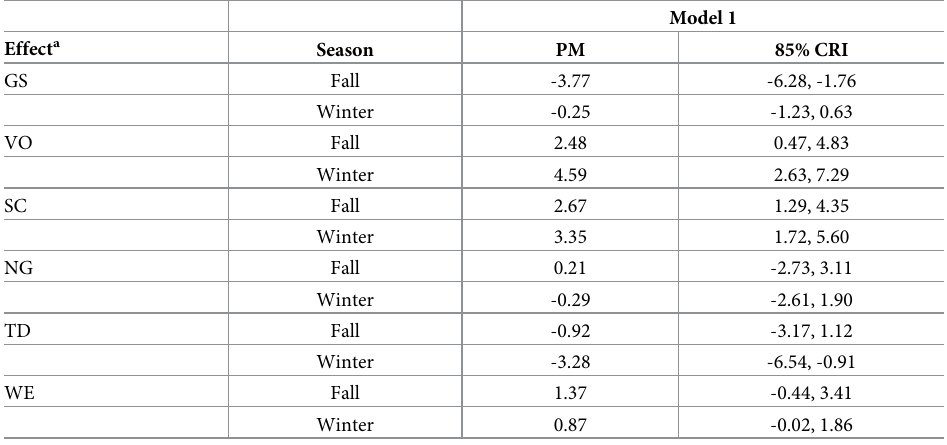
Table 3. Posterior means and 85% credible intervals (CRI) for landscape, vegetation, and management effects from discrete choice models for fall (Nov) and winter (Dec–Jan) resource selection of Northern bobwhite in south- west Missouri,